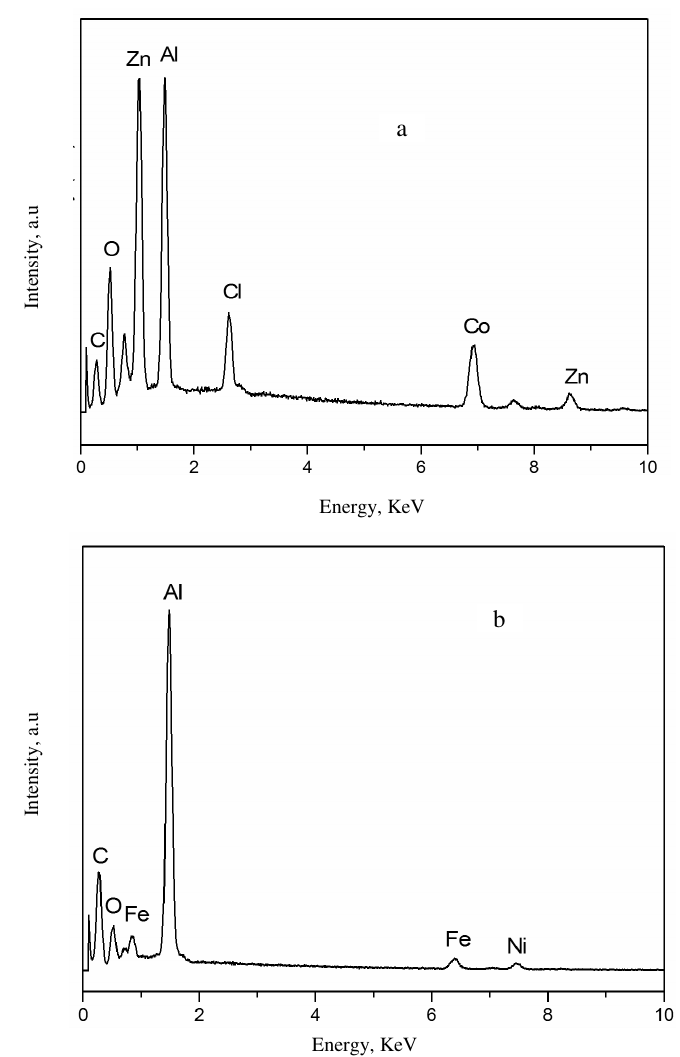
Figure 3. EDS spectra of carbon nanotube prepared from (a) Co/Zn/Al and (b) Fe/Ni/Al catalysts. The HR-TEM micrograph of the prepared CNTs from the catalysts Co/Zn/Al and Fe/Ni/Al, by decomposition of ethyne (acetylene) are presented in Figure 4. The TEM image at 20 nm magnification, Figure 4(a and b), of the prepared carbon nanotubes obtained from the catalyst Co/Zn/Al shows several particles of solid catalyst along a strand of a nano carbon fiber. The figure also show a cluster of amorphous carbon with black dots which are thought to be metallic nanoparticles of catalysts with a single carbon nanotubes at 50 nm. The HR-TEM micrograph of the prepared CNTs from the catalyst Fe/Ni/Al, Figure 4(b and c), at 200 and 20 nm magnifications is a typical high resolution TEM image of carbon nanotubes. The images at these magnifications indicate that there are catalyst particles encapsulated with the grown CNT which show that the CNT grew from the catalyst